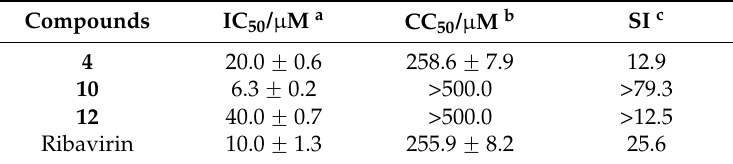
Table 3. Anti-RSV activity of the active compounds ( n =